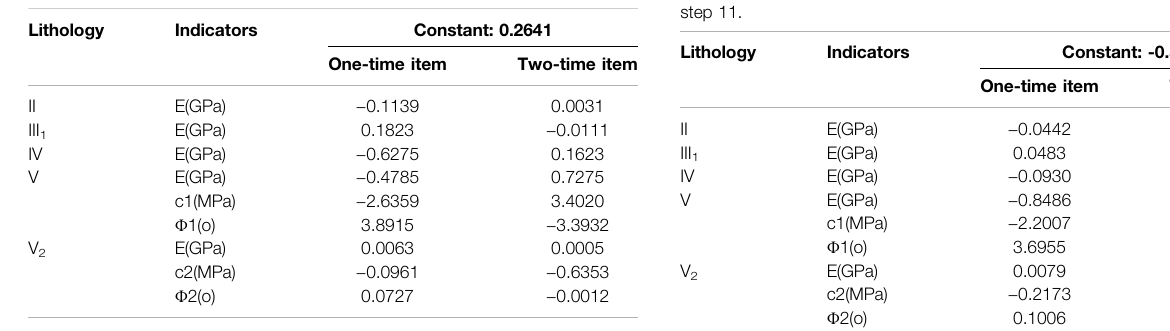
TABLE 8 | Response surface equation coef fi cients before excavation. TABLE 9 | Response surface equation coef fi cients at the end of excavation in